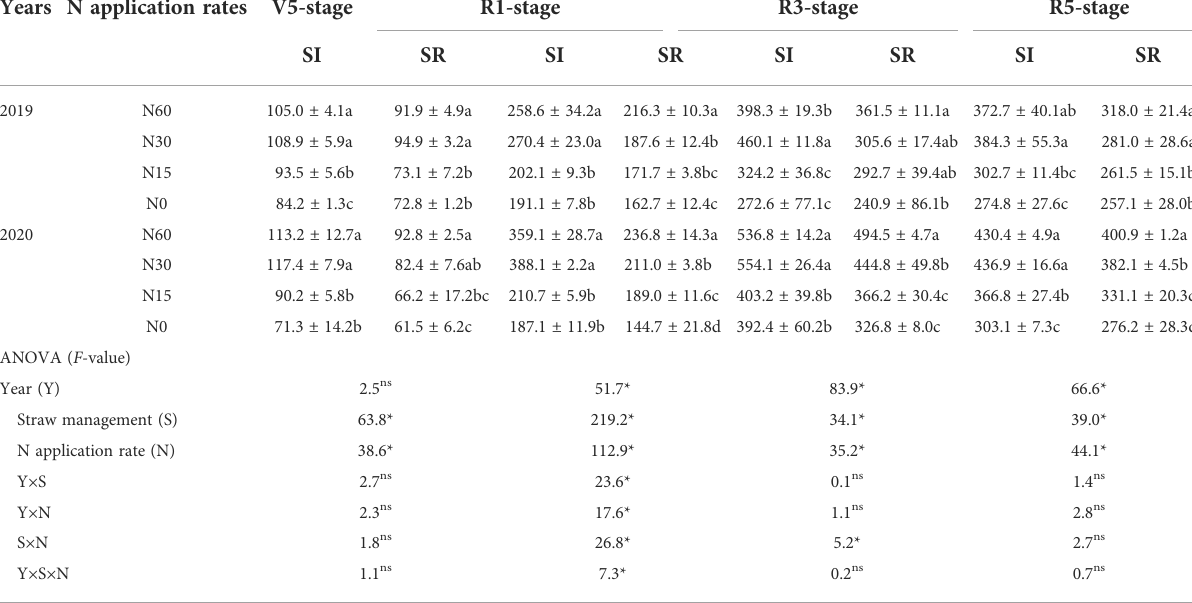
Different lower-case letters indicate signi fi cant differences under different N application rates (LSD, P< 0.05); Data were shown as mean ± S.D. (n=3); The asterisk “ * ” and “ ns ” indicate signi fi cantdifference(P<0.05)andinsigni fi cantdifference(P>0.05),respectively;SI,strawincorporation;SR,strawremoval;N60,conventionN(60kgNha -1 );N30,reducedNby50%(30